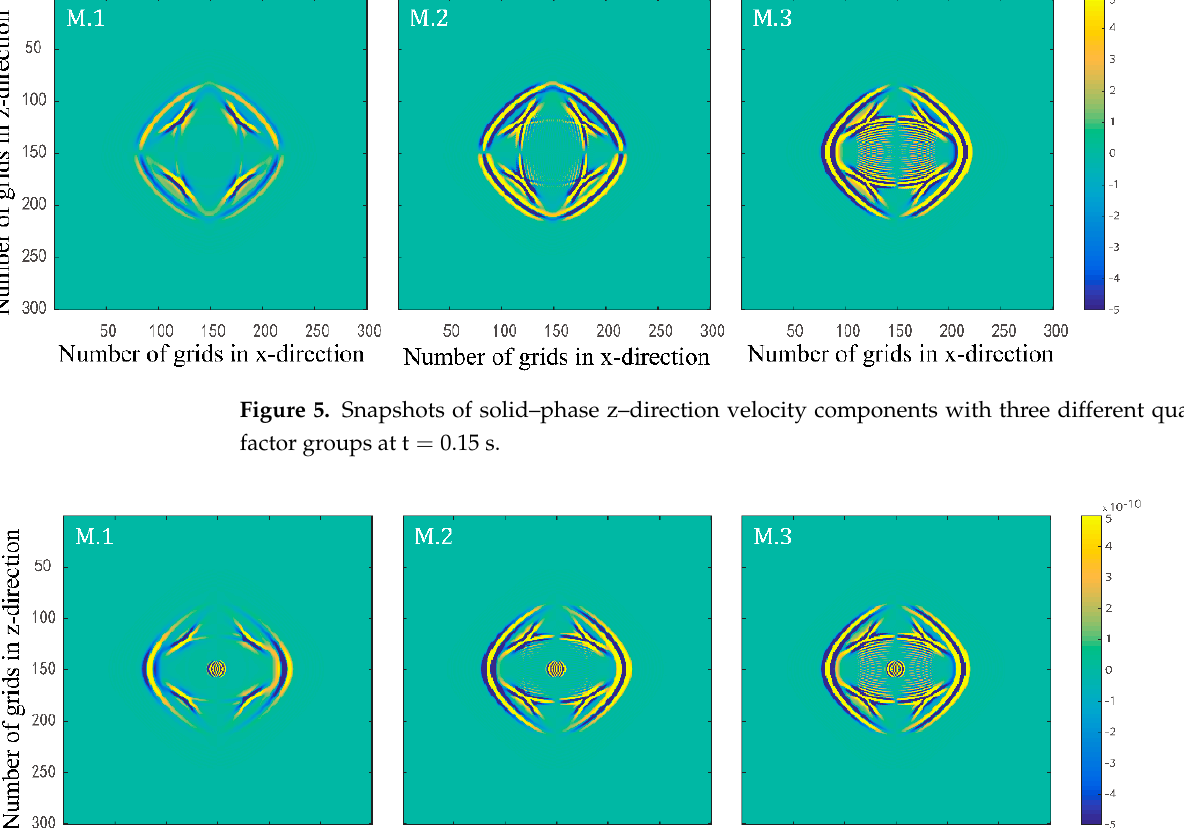
Figure 8. Comparison of liquid–phase x–direction velocity components with three different quality factor groups at point (cid:4666)160,160(cid:4667) . In Figures 5 and 6, the amplitudes of the waves all enhance as the quality factors increase. As the quality factors increase, the viscoelasticity of the solid skeleton becomes weaker, and the attenuation of elastic waves becomes weaker. As a result, the amplitudes of the waves enhance in both solid and liquid phases. One of the most important features